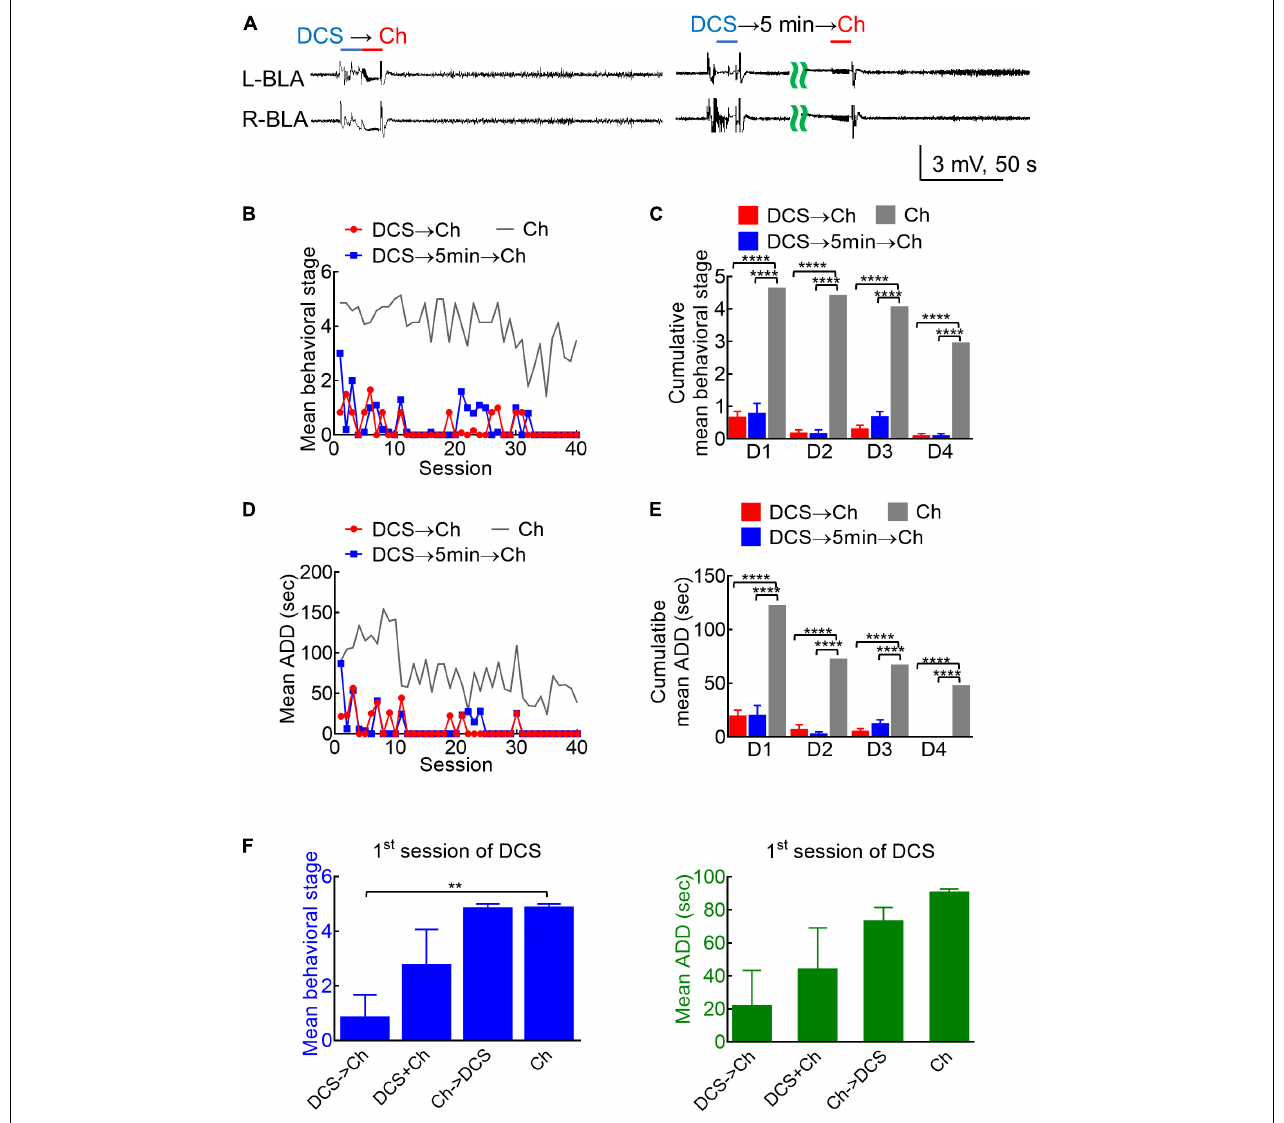
FIGURE 4 | Marked anticonvulsant effect of DCS in fully kindled rats if given immediately before or 5 min before the challenge stimuli. (A) Sample LFP shows that 100 µ A, 10-s DCS right before (DCS → Ch, left panel) or 5 min before challenge (DCS → 5 min → Ch, right panel) markedly suppresses AD in bilateral BLA (and the rat expressed no seizure behaviors). (B) The mean behavioral stage during each session of stimulation by DCS given immediately before or 5 min before the challenge stimulus (DCS → Ch, red symbols, n = 6; DCS → 5 min → Ch, blue symbols, n = 5) is markedly lower than that with a challenge only (Ch, gray symbols, n = 7). Only the mean values are shown for the sake of clarity. The gray line is the control data taken from Figure 3B and replotted for comparison. (C) The cumulative mean behavioral stage in each of the 4 days is lower in both DCS groups if compared to the challenge only group ( n = 10, 10, 10 each day from the mean of 6, 5, 7 rats for DCS → Ch, DCS → 5 min → Ch, and Ch group, respectively). (D) The mean ADD from L-BLA after each challenge stimulation is shortened by DCS given before or 5 min before the challenge (DCS → Ch, red symbols, n = 4; DCS → 5 min → Ch, blue symbols, n = 3). The gray line is the control data taken from Figure 3D